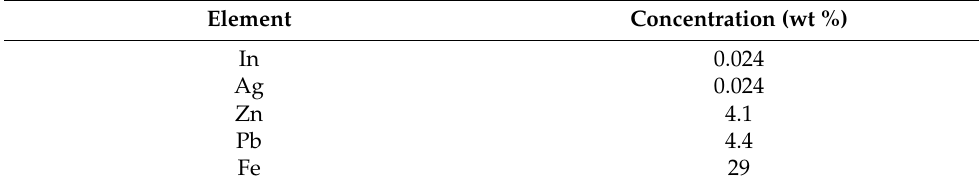
Table 1. Chemical composition of the investigated mixture.